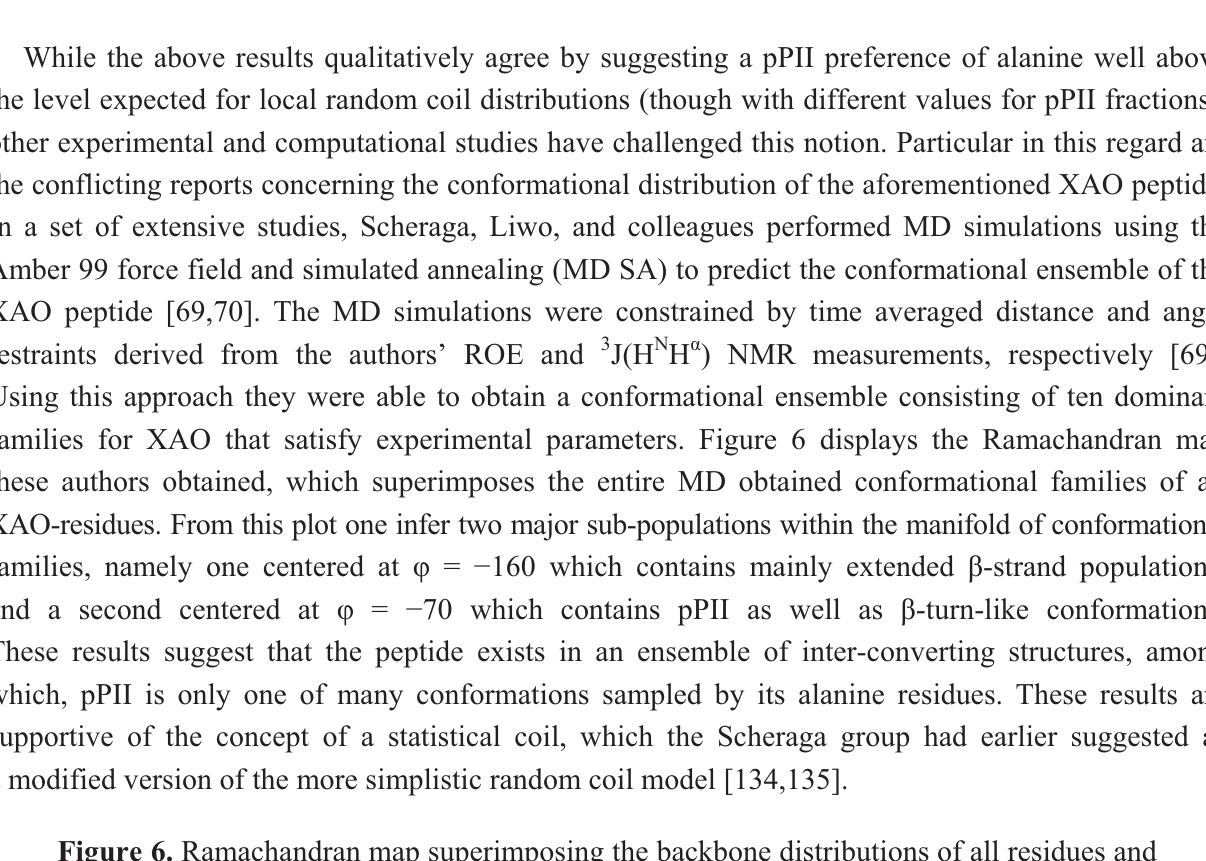
Figure 6. Ramachandran map superimposing the backbone distributions of all residues and all conformational families of the XAO peptide calculated by MD SA with NMR derived time-averaged restraints. The green boxes indicate the two dominant conformational clusters centered at (cid:10) = (cid:6)160°, (mainly extended (cid:8)-strand-like structures) and (cid:10) = (cid:6)70° (pPII and (cid:8)-turn-like conformations). (Taken from ref. [69] and